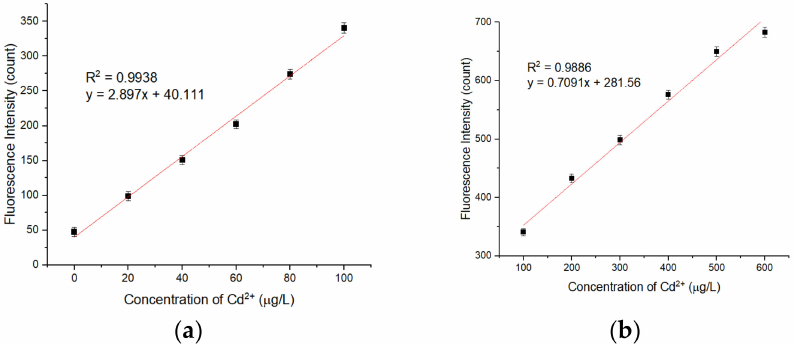
Figure 10. ( a ) Corresponding calibration plots for the APDC / CdTe / CdS QD solution based on di ff erent Cd 2 + concentrations in Tris-HCl bu ff er solution. Concentration of Tris-HCl bu ff er solution: 10 mmol / L. pH of Tris-HCl bu ff er solution: 8.5. Concentration of added QD solution: 5 µ mol / L. Concentration of APDC solution: 100 µ mol / L. Concentration of cadmium standard solution: 1 g / L. Addition order: Tris-HCl bu ff er solution (2 mL) → QD solution (0.4 mL) → APDC solution (0.52 mL) → cadmium standard solution (0–0.0004 mL) → Tris-HCl bu ff er solution (1.08 mL). Excitation wavelength: 460 nm. Observation time: 3 min. * Mean of five measurements. ( b ) Corresponding calibration plots for the APDC / CdTe / CdS QD solution based on di ff erent Cd 2 + concentrations in Tris-HCl bu ff er solution. Concentration of Tris-HCl bu ff er solution: 10 mmol / L. pH of Tris-HCl bu ff er solution: 8.5. Concentration of added QD solution: 5 µ mol / L. Concentration of APDC solution: 100 µ mol / L. Concentration of cadmium standard solution: 1 g / L. Addition order: Tris-HCl bu ff er solution (2 mL) → QD solution (0.4 mL) → APDC solution (0.52 mL) → cadmium standard solution (0.0004–0.0024 mL) → Tris-HCl bu ff er solution (1.08–1.0776 mL). Excitation wavelength: 460 nm. Observation time: 3 min. All data in this figure is mean of five